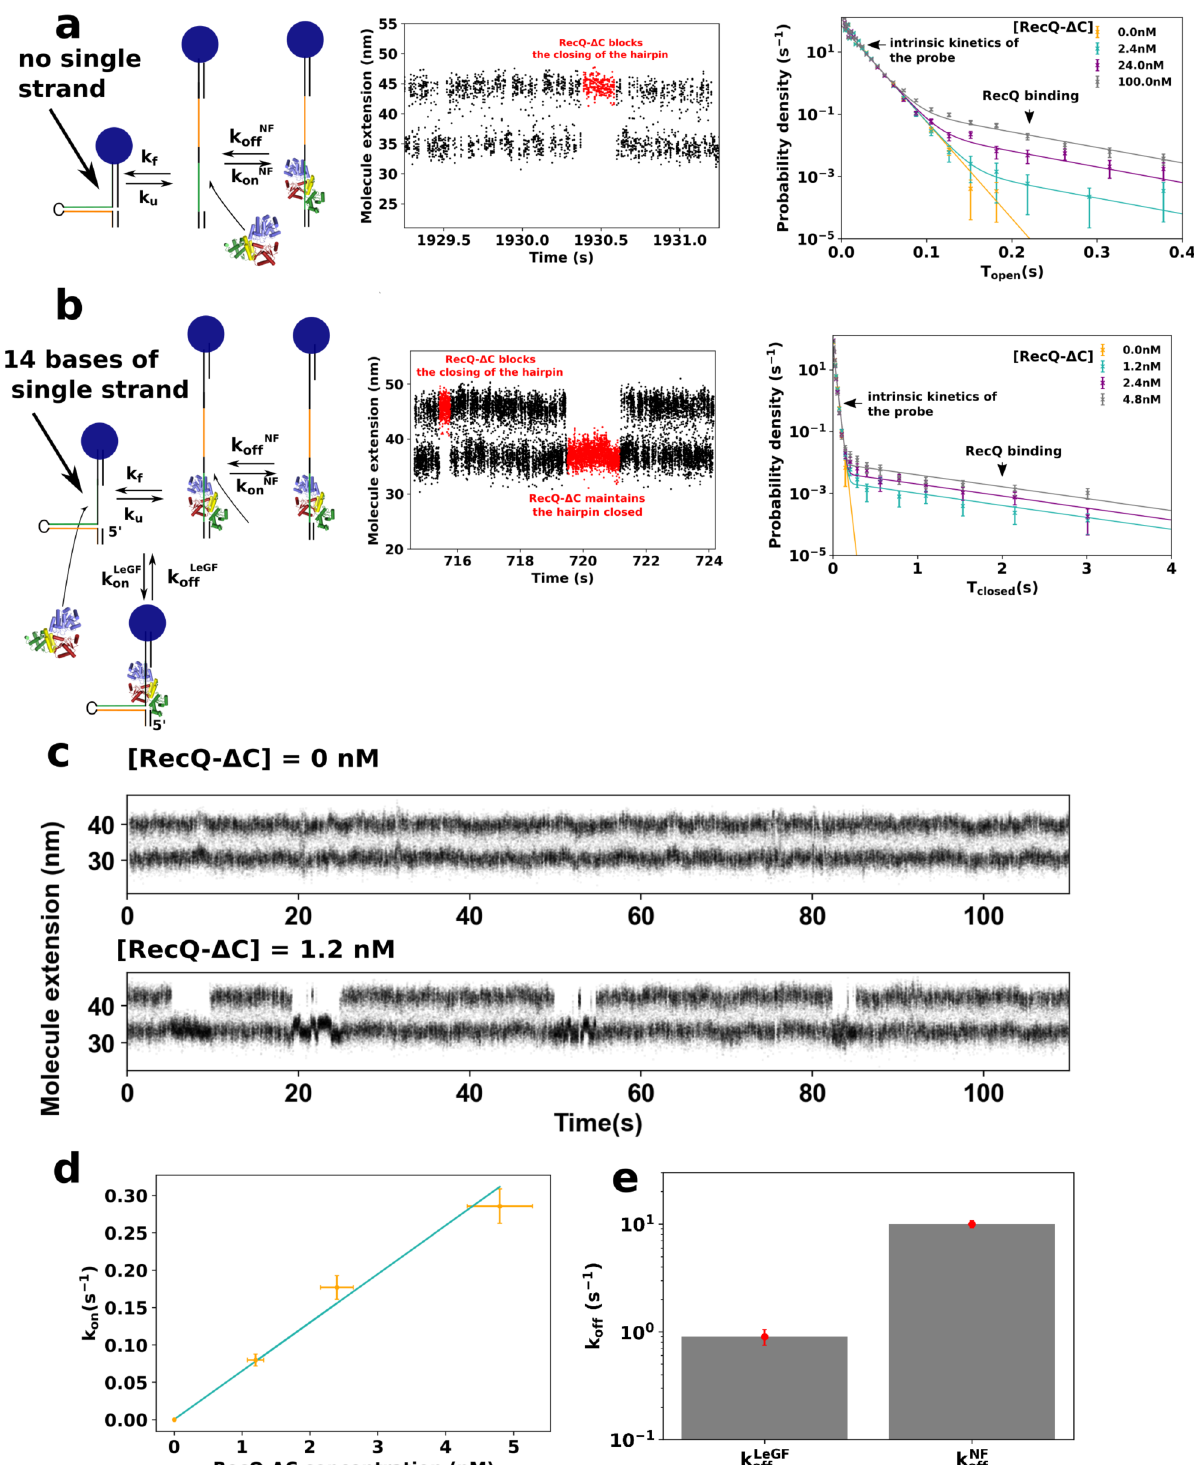
of synthesized ssDNA of length, respectively, 160, 153, and 139 bases. Once hybridized to Oli1 and Oli2, the size of the remaining ssDNA reduces to (45/38/24) bases. Twenty-four of these bases fold into a 10 bp hairpin with a 4-base apex T-loop. The fl uctuating probe used to measure oligonucleotide binding is HP1. Once the hairpin is hybridized, 7 ss bases are left on the 5 ′ side and 14 on the 3 ′ side. Measurements are performed in hybridization buffer (20 mM Tris-HCl pH 7.6, 3 mM MgCl 2 , 100 mM KCl). The oligonucleotides are ordered dry